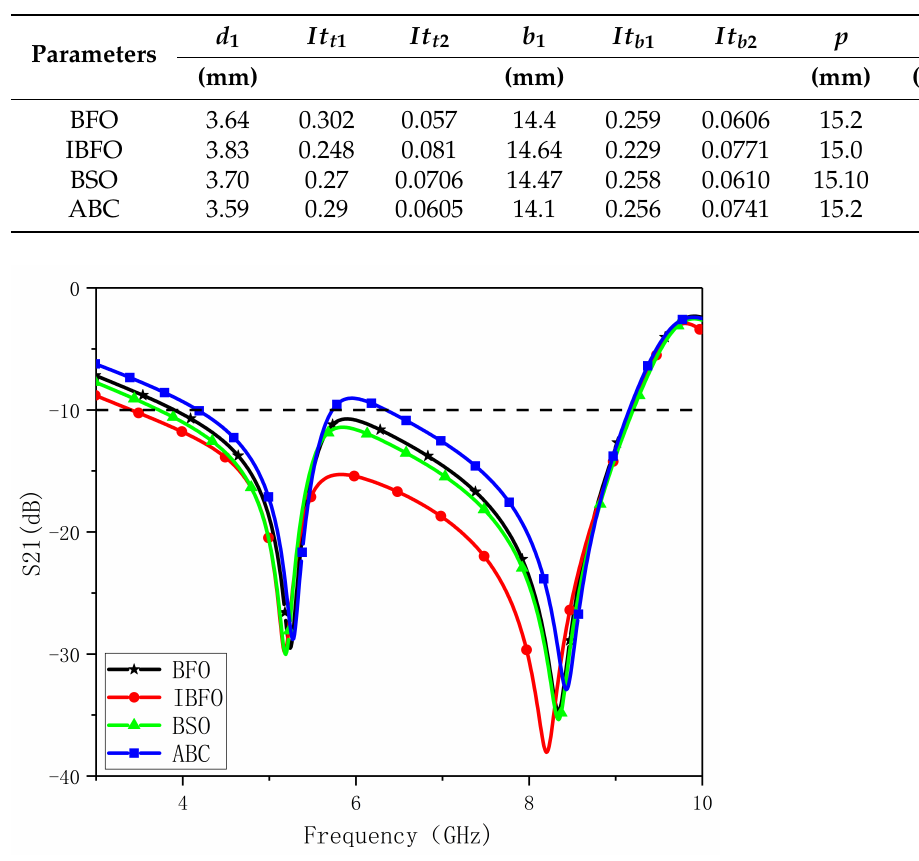
Table 4. Optimized parameters obtained by different algorithms.